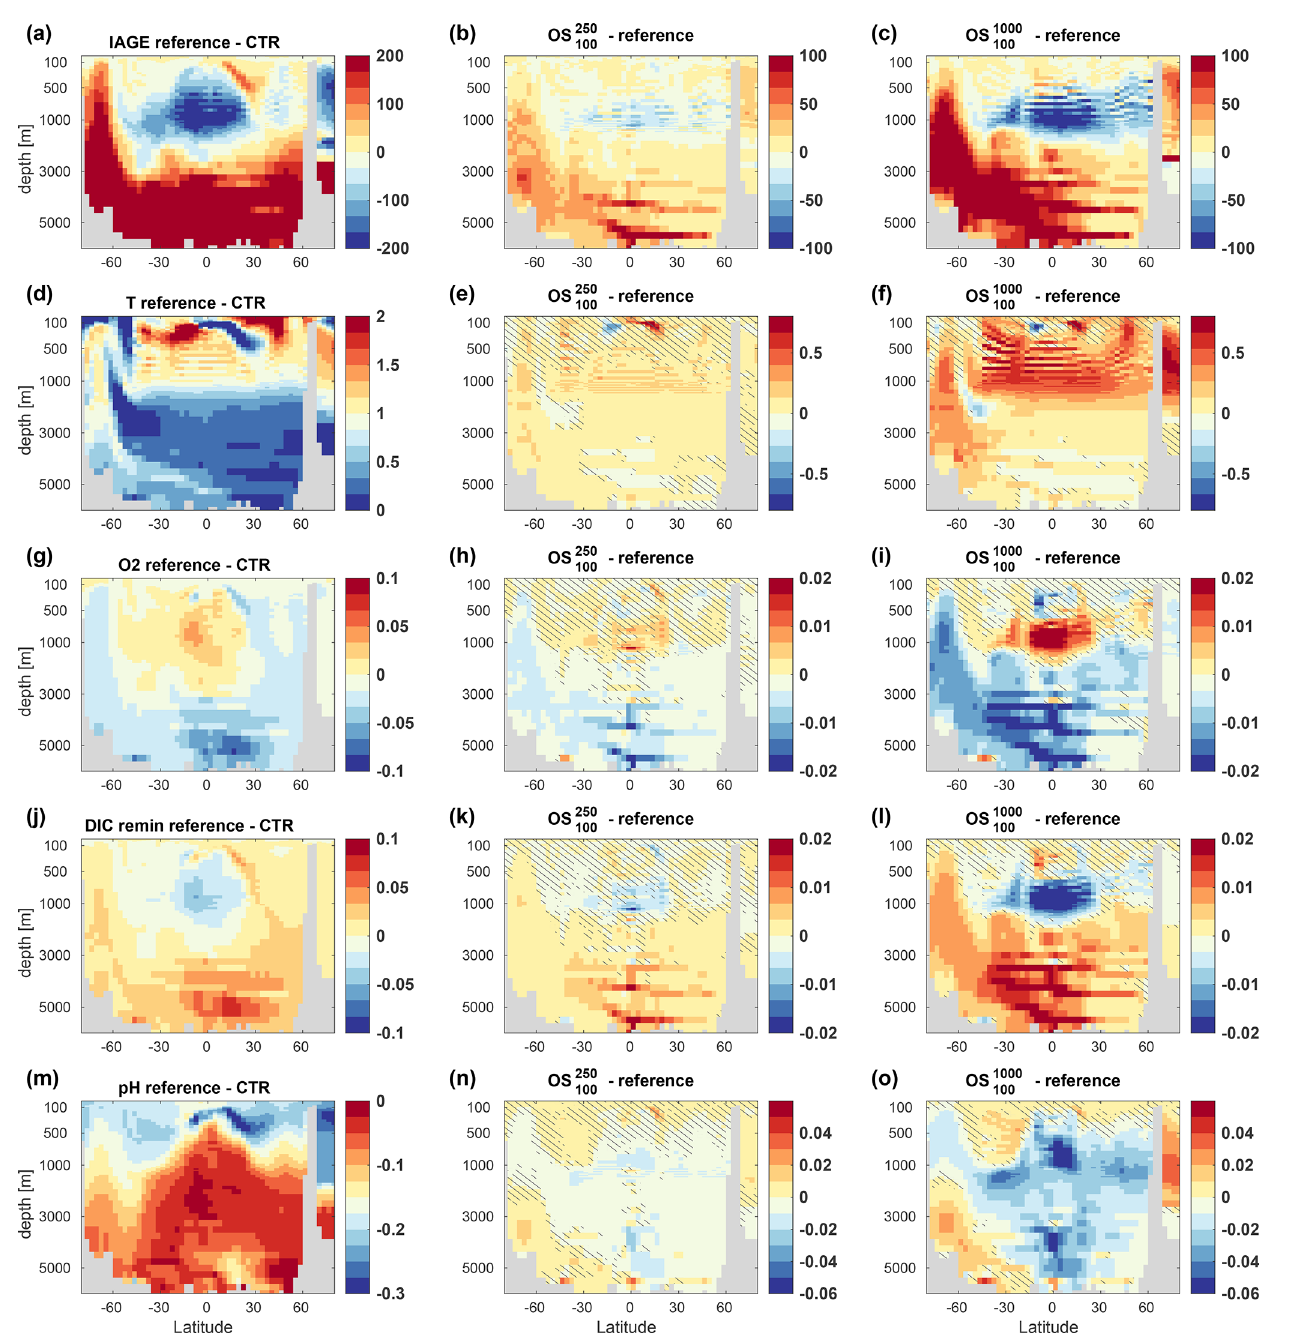
Figure 10. Anomalies of seawater ideal age (a–c) , potential temperature (d–f) , dissolved oxygen (g–i) , remineralized DIC (j–l) , and pH (m– o) for a zonal mean section through the Pacific (between 180 and 140 ◦ W). Panels (a, d, g, j, m) display the difference between the reference simulation B 1500 and the pre-industrial control run (CTR), while panels (b, c, e, f, h, i, k, l, n, o) show the anomalies of the long overshoot simulations OS 250 , and OS 1000 relative to the reference. Shown is the ensemble mean averaged over the last 11 years of our simulations 100 100 (years 390–400), and the hatched areas indicate reversibility (REV 95 ) according to our definition. Corresponding figures for a section through the Atlantic Ocean and for the short overshoots are shown in Appendix